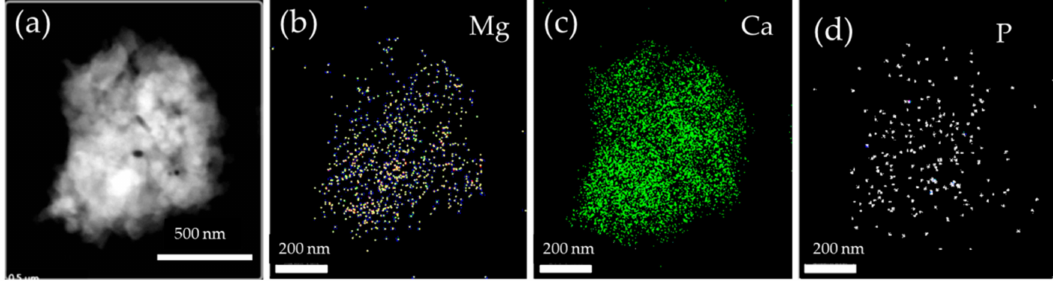
Figure 6. STEM images and elemental mapping of Mg-rich calcite: ( a ), image of Mg-rich calcite; ( b ), ( c ), and ( d ), represent the distribution of Mg, Ca and P elements, respectively, within Mg-rich calcite